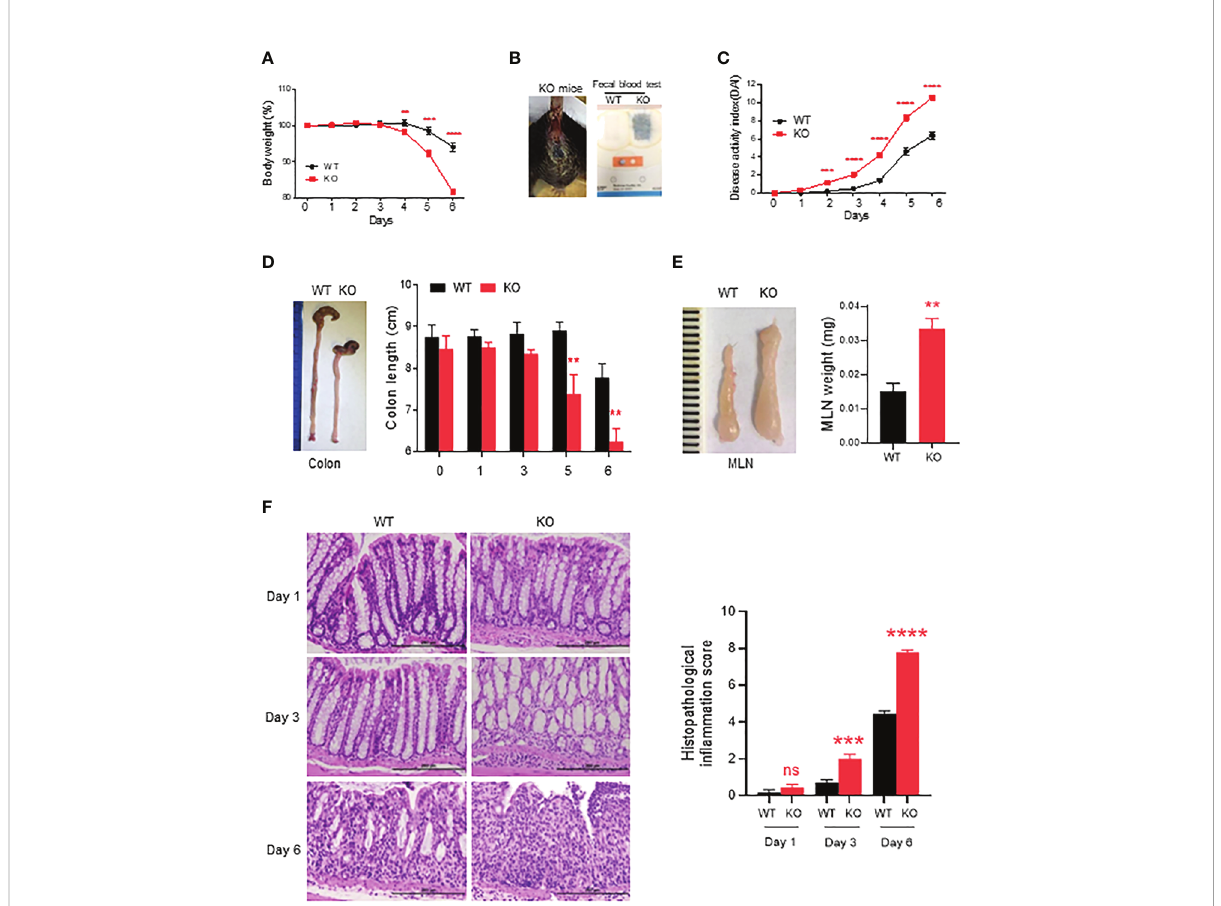
FIGURE 1 Severe acute colitis induced by DSS in AKR1B8 de fi cient mice. AKR1B8 KO and wild type mice were treated with 1.5% DSS in drinking water for 6 days. (A) Body weight measured daily. (B) Bleeding in AKR1B8 KO mice. Right panel , fecal occult blood tests. (C) Disease activity index (DAI). (D) Colon length on day 6. (E) Mesenteric lymph nodes (MLNs) on day 6 (n=6). (F) Histological assessment of colonic tissues during the course (day1, day3 and day6) of acute colitis induction. Right panel , histopathological in fl ammation. Scale bar, 200 m m. KO, knockout; WT, wild type. **p < 0.01; ***p < 0.001 and ****p < 0.0001; ns, No Signi fi